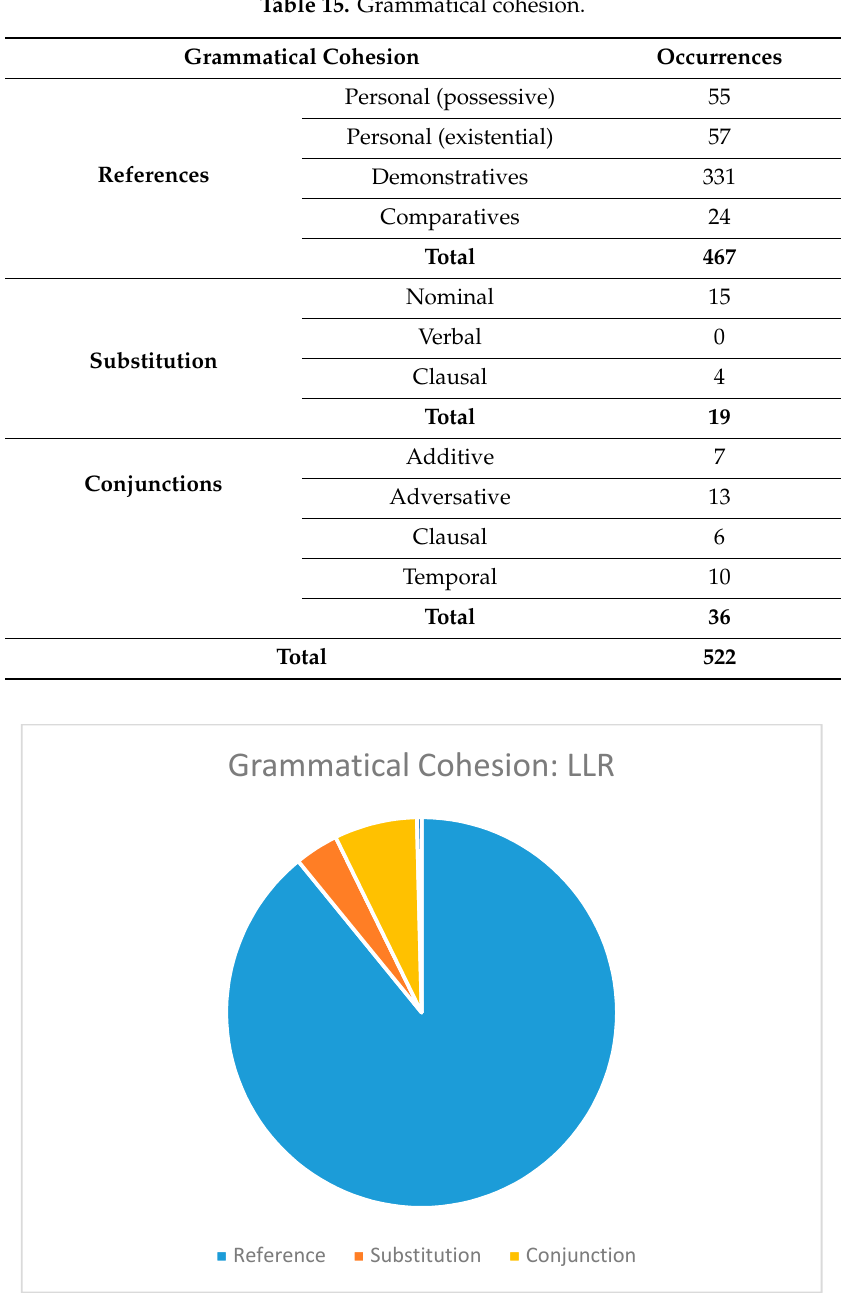
Table 15. Grammatical cohesion.